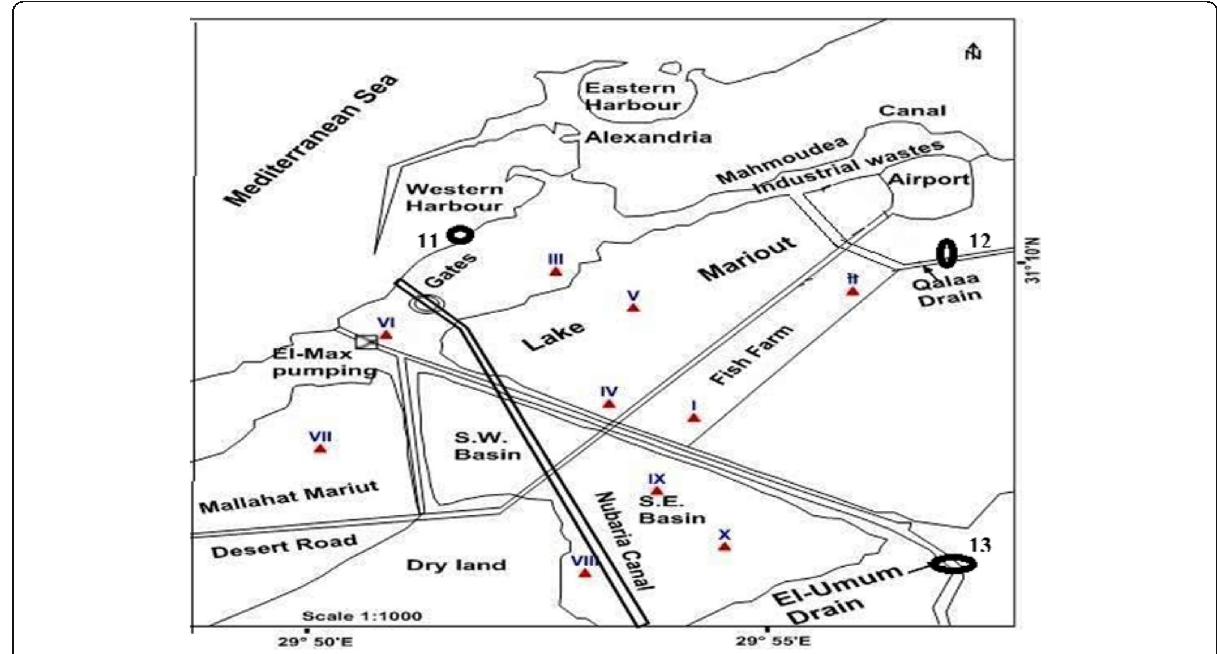
Fig. 1. A map of Lake Mariout showing the sampling sites: Stations 1 and 2 (I, II): inside the fish farm; Station 3 ( III): The Qalah outlet; Station 4 (IV): Abh El Khir Bridge; Station 5 (V): Main Basin; Station 6 (VI):El Omoum outlet; Station 7 (VII): 2000 Feddan Basin, Stations 8 and10 (VIII and X): 5000 Feddan Basin; and Station 9 (IX): Gas Basin, in addition to three locations, 11, 12, and13, for the draining